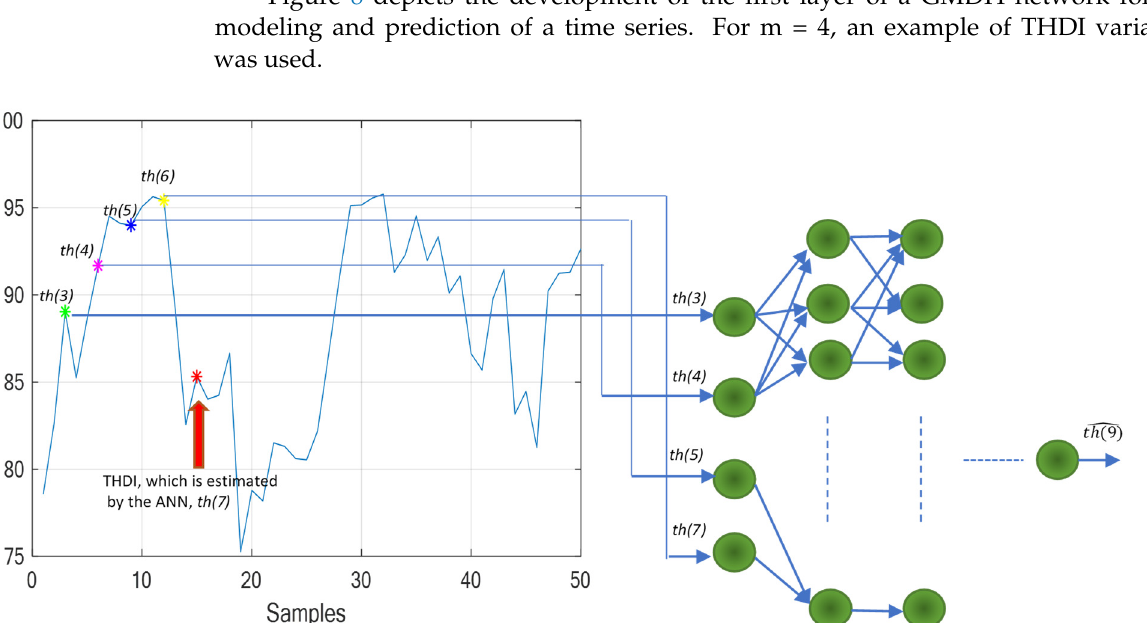
Figure 8. The development of the first layer of an ANN—GMDH for time series modeling and pre- diction.